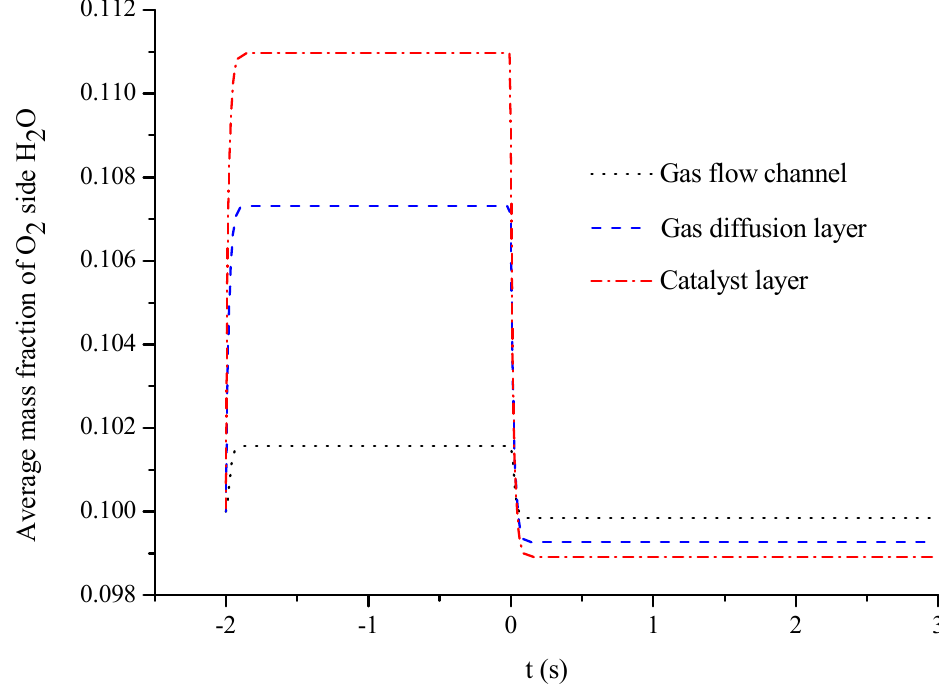
Figure 9. Time ‐ dependent evolution of H 2 O mass fraction in different layers. Figure 9. Time-dependent evolution of H 2 O mass fraction in different